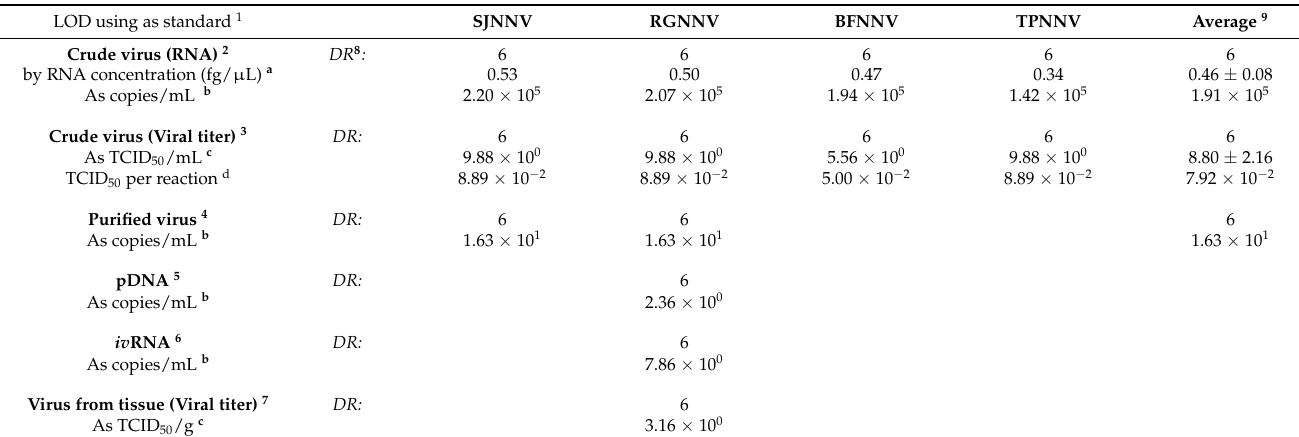
Table 2. Sensitivity and dynamic